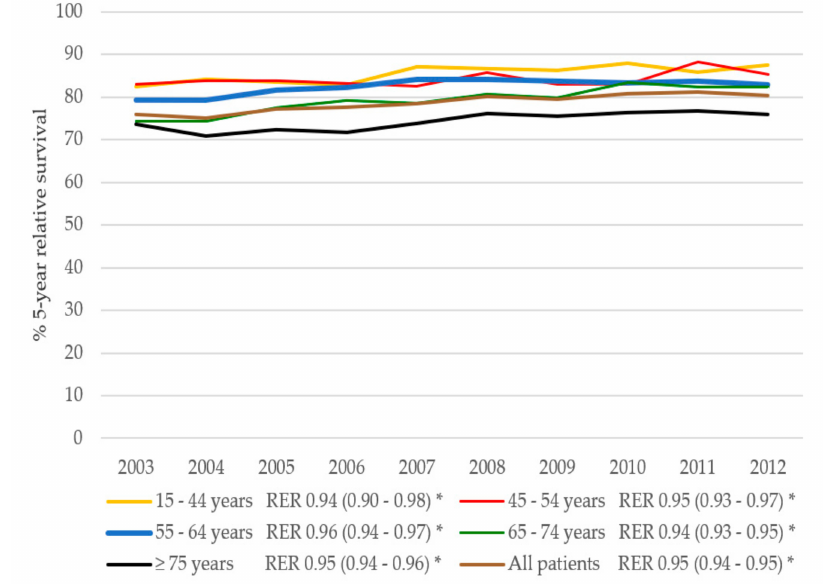
Figure 7. Five-year relative survival in CRC patients over time per age group. RER indicates the relative excess risk per year, adjusted for grade, stage, gender, and treatment. * Significant ( p <